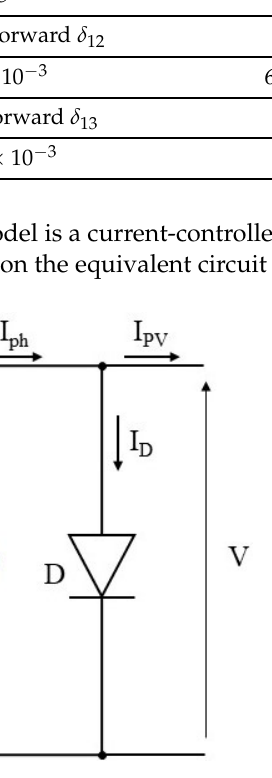
Figure 14. Schematic of the PV